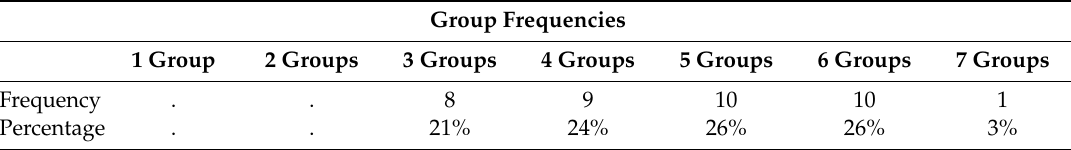
Table 1. Frequency of grouping solutions for 12 geometric shapes, based on 38 participants. Group